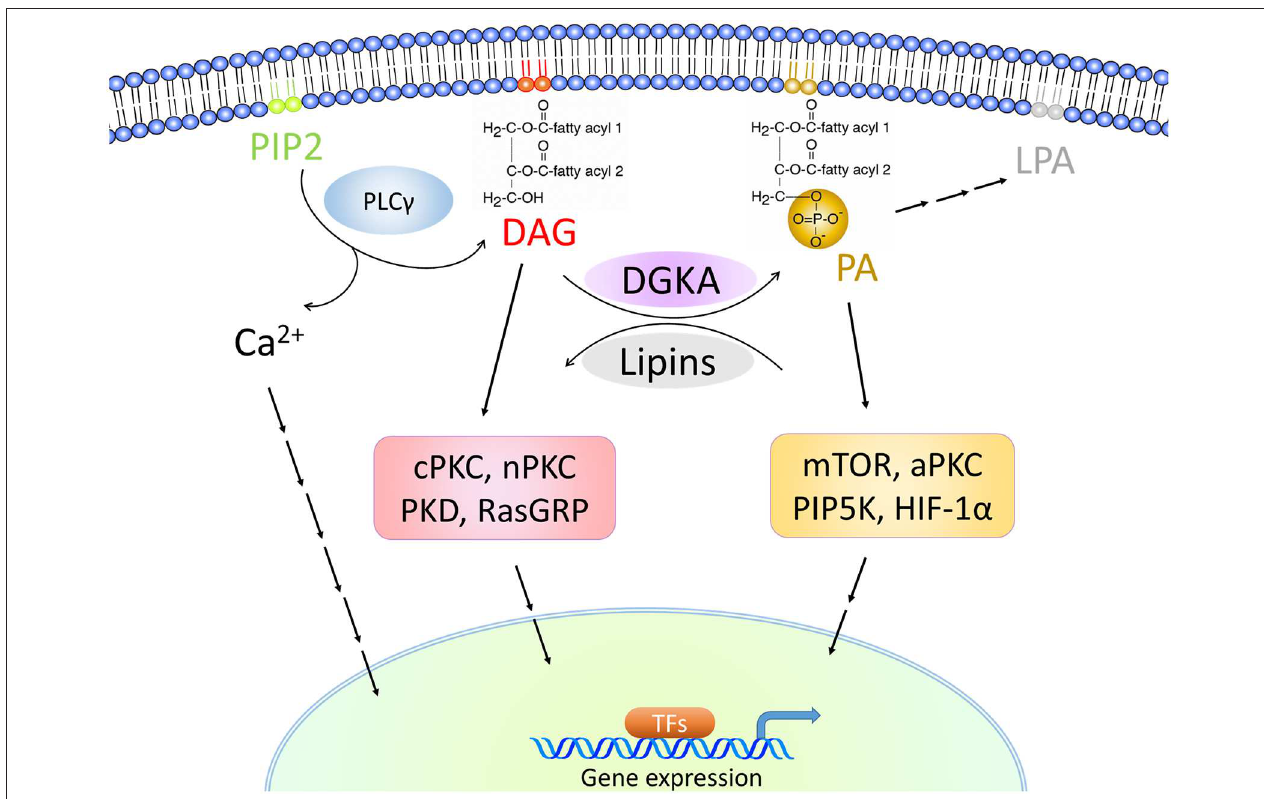
FIGURE 4 | DGKA-associated signaling cascades. DGKA controls the conversion of DAG to PA, two membrane-associated lipid messengers. High DAG levels activate classical PKCs (cPKC) with PKC α , β and γ , novel PKCs (nPKC) with PKC δ , ε , η , and θ , PKD and RasGRP signaling. High PA levels activate mTOR, atypical PKCs (aPKC) with PKC ζ and PKC ι / κ , PIP5K, and HIF-1 α . The stimulated signaling cascades induce transcription in the nucleus by triggering pathway-specific transcription factors (TFs).